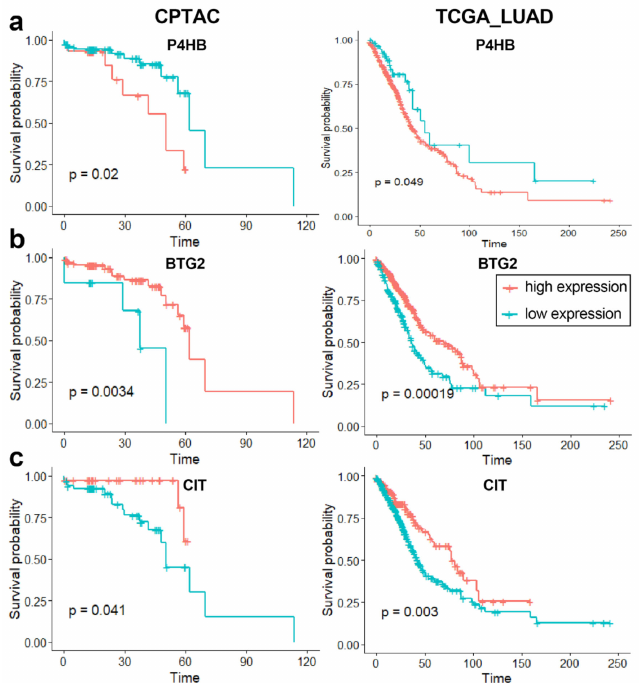
Figure 13. Kaplan–Meier survival analysis results for ( a ) P4HB, ( b ) BTG2 and ( c ) CIT in CPTAC and TCGA-LUAD